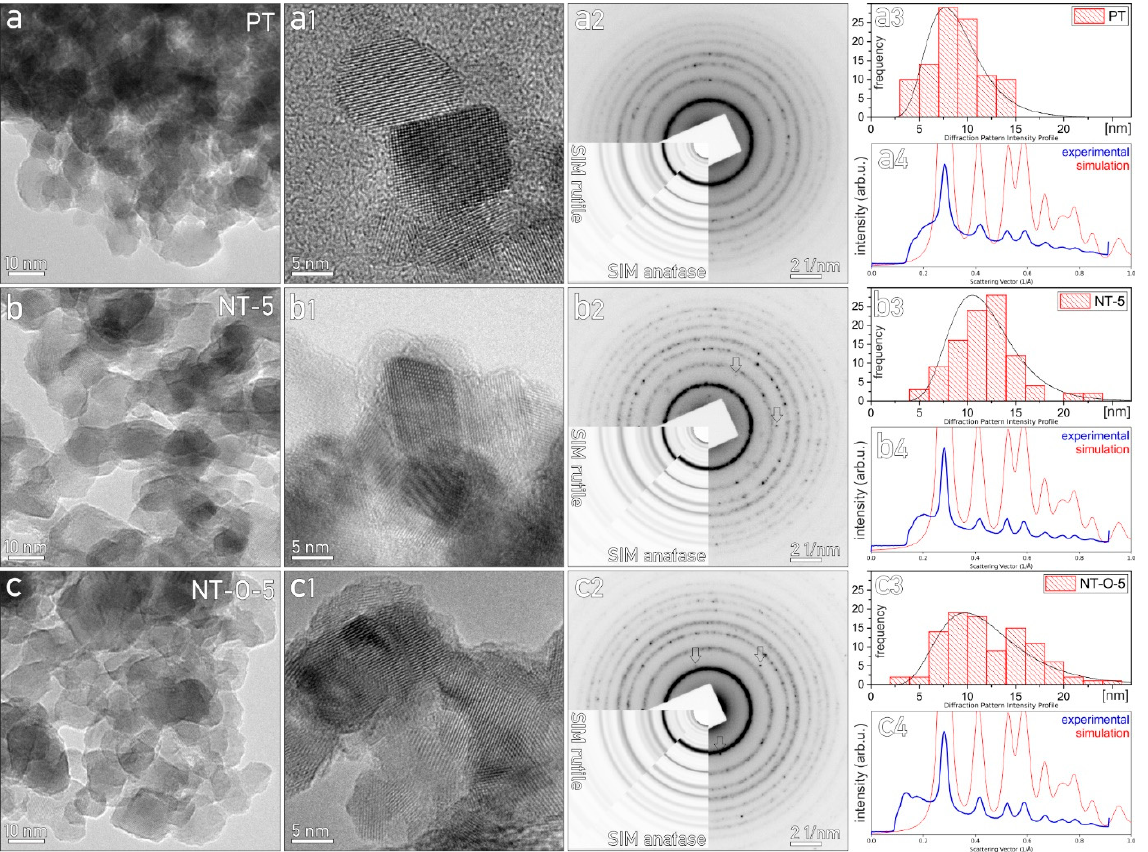
Figure 2. TEM analysis of samples: ( a ) PT, ( b ) NT-5, and ( c ) NT-O-5. ( a – c ) overview TEM micrograph, ( a1 – c1 ) HR-TEM micrographs, ( a2 – c2 ) SAEDP with simulation insets for anatase and rutile, arrows mark the characteristic rutile reflections; ( a3 – c3 ) particle size distribution graph with lognormal distribution curve (normalized to max.), and ( a4 – c4 ) experimental SAEDP intensity profile (blue) with simulation for anatase (red).